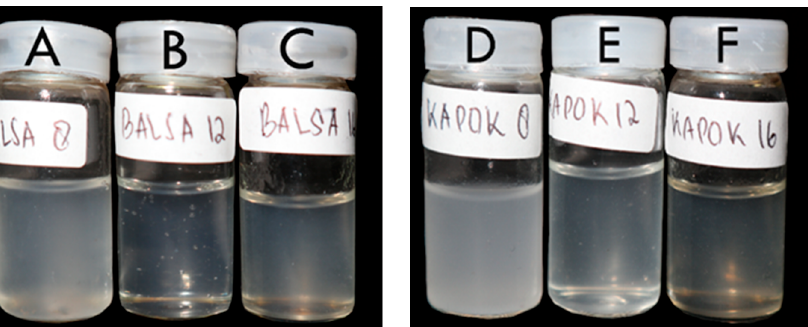
Figure 2. Appearance of CNC suspensions after oxidation using the APS method with different oxidation times. ( A ) Balsa, 8 h oxidation; ( B ) balsa, 12 h oxidation; ( C ) balsa, 16 h oxidation; ( D ) kapok, 8 h oxidation; ( E ) kapok, 12 h oxidation, and ( F ) kapok, 16 h oxidation.